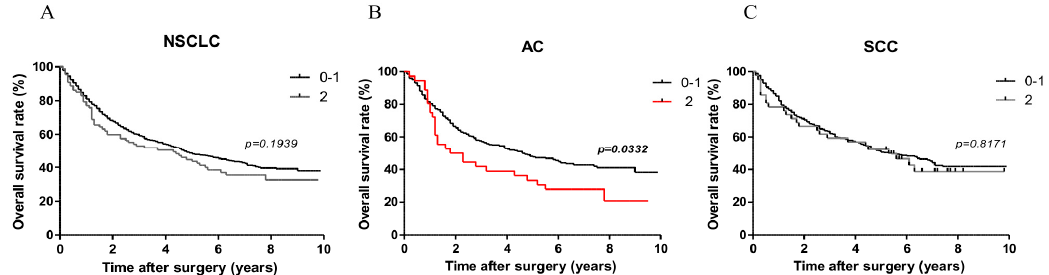
Figure 4. Patients with low PD-L1 expression (0–1 point) had longer survival compared to the group